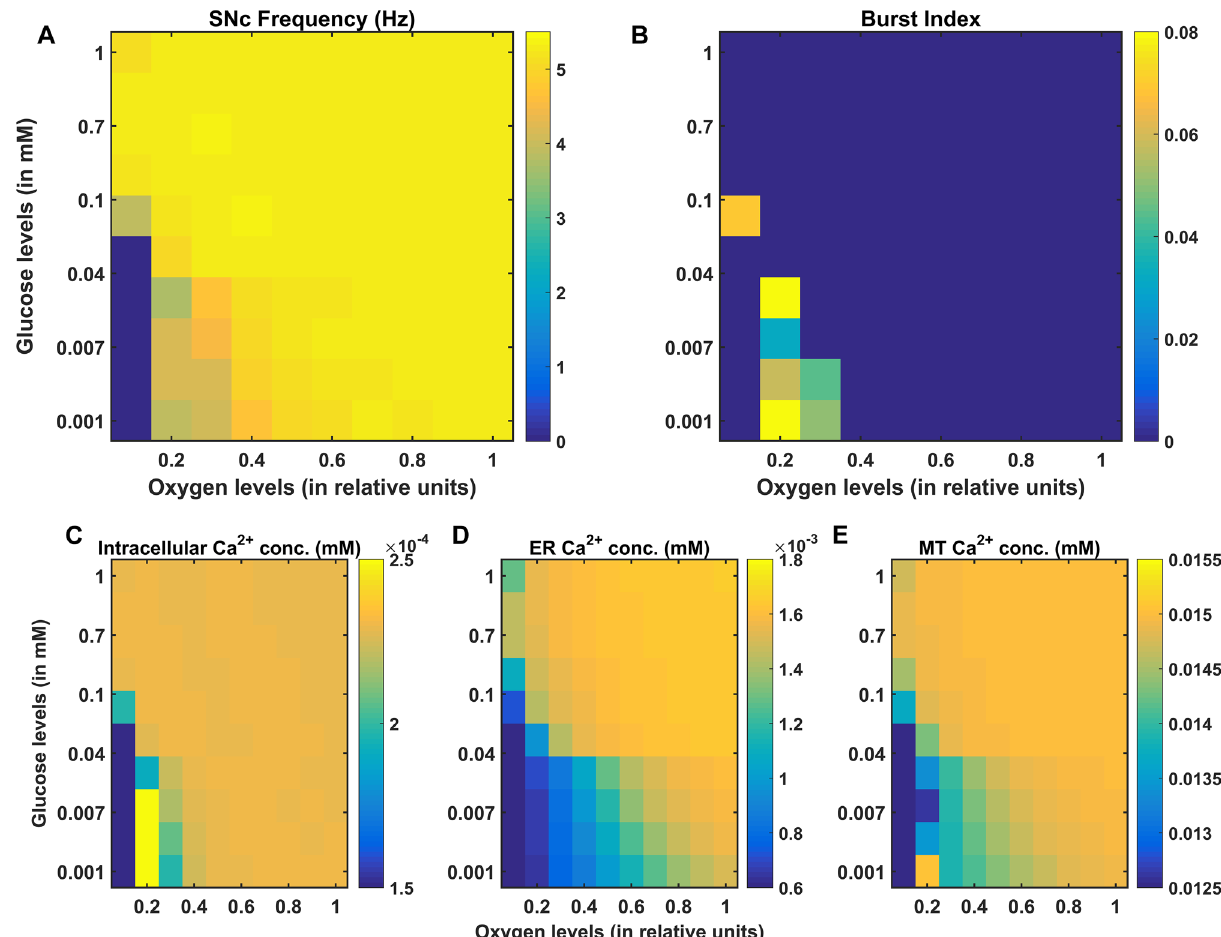
Figure 5. Model response to hypoglycemia and hypoxia conditions. Average frequency of firing ( A ), Bursting ( B ), average intracellular calcium (Ca 2+ ) concentration ( C ), average endoplasmic reticulum (ER) calcium concentration ( D ), and average mitochondrial (MT) calcium concentration ( E ) of the model for varying glucose and oxygen concentrations. SNc Substantia Nigra pars compacta, conc concentration, mM millimolar, Hz